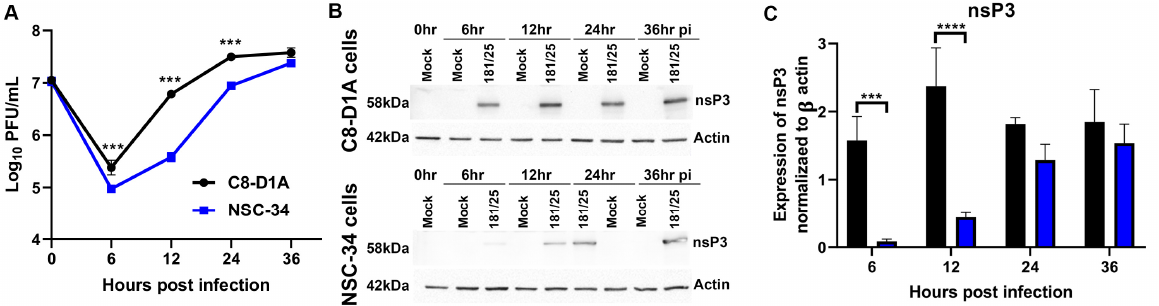
Figure 1. CHIKV replicates more efficiently in mouse C8-D1A astrocytic cells than NSC-34 neuronal cells. Cells were infected with CHIKV 181/25 at an MOI of 5 as measured by plaque assay on Vero cells. ( A ) Production of infectious virus by C8-D1A cells and NSC-34 cells. Data are presented as the geometric mean +/ − SD from two independent experiments each performed in triplicate. *** p < 0.001 ( B ) Representative immunoblots for expression of nsP3 6, 12, 24 and 36 h post infection (hpi) of C8-D1A (top) and NSC-34 (bottom) cells. ( C ) Amounts of nsP3 produced in C8-D1A compared to NSC-34 cells after infection. Blots from three separate experiments were scanned, quantified with Image J, band densities normalized to actin, and ratios compared with Student’s t test. *** p < 0.001; **** p < 0.0001.